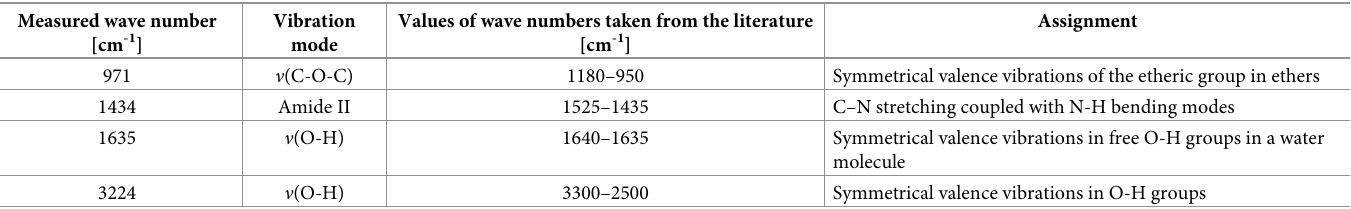
Table 4. Assignment of vibration modes of interaction of anthracycline cytostatics with a titanium surface. Measured wave number Vibration Values of wave numbers taken from the literature Assignment [cm -1 ] mode [cm -1 ] Symmetrical valence vibrations of the etheric group in